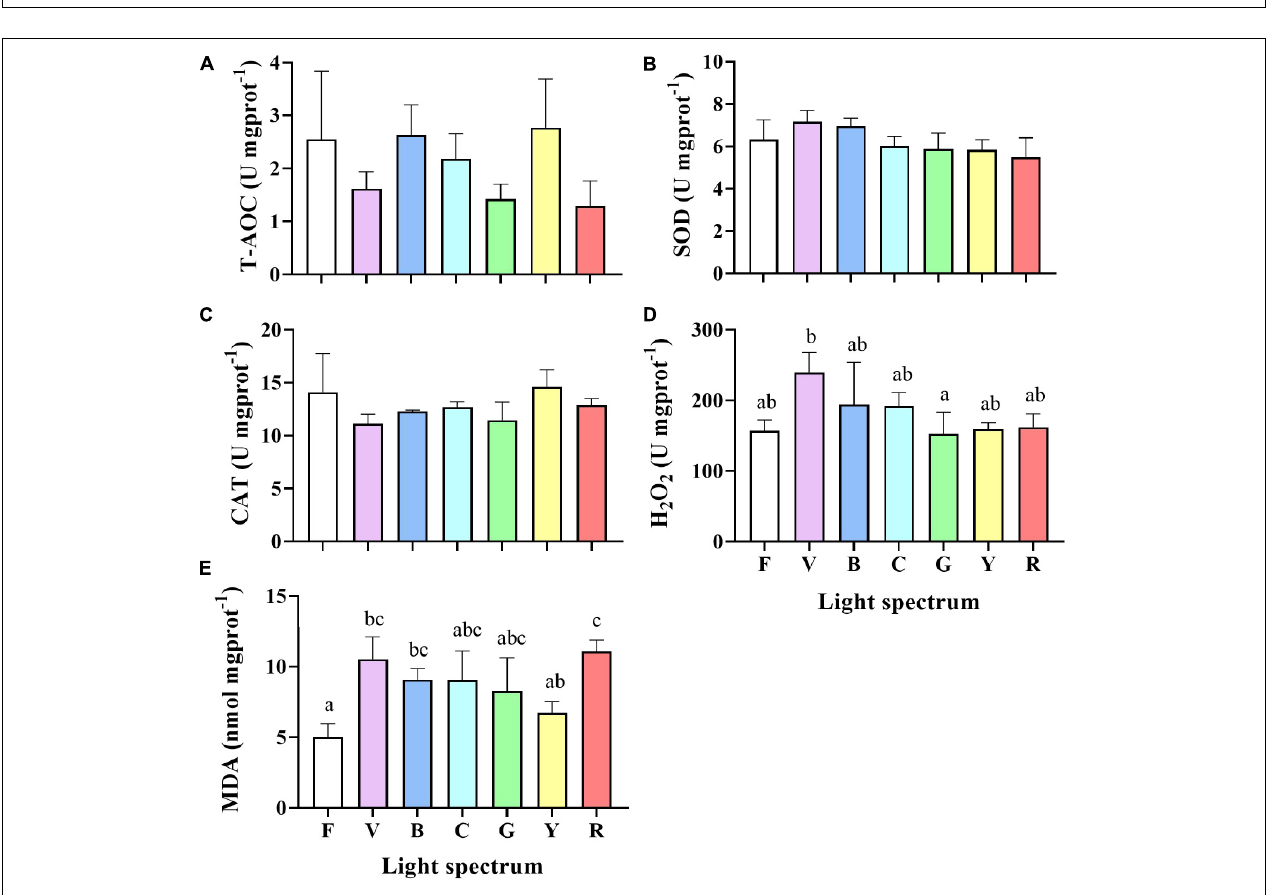
FIGURE 5 | Melatonin (A) and cortisol (B) levels in eyestalks of S. paramamosain reared under various light spectrum. Values are expressed as means ± SD ( n = 3, 2 individuals per replicate). F, Full spectrum; V, Violet; B, Blue; C, Cyan; G, Green; Y, Yellow; R, Red. Different superscripts denote significant differences between treatments ( P <